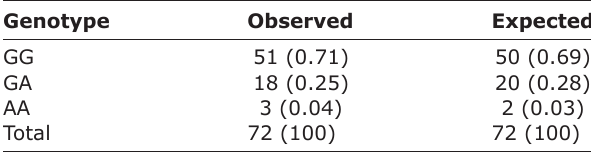
Table-1: Number of observed and expected genotypes (relative frequencies are reported in parenthesis).